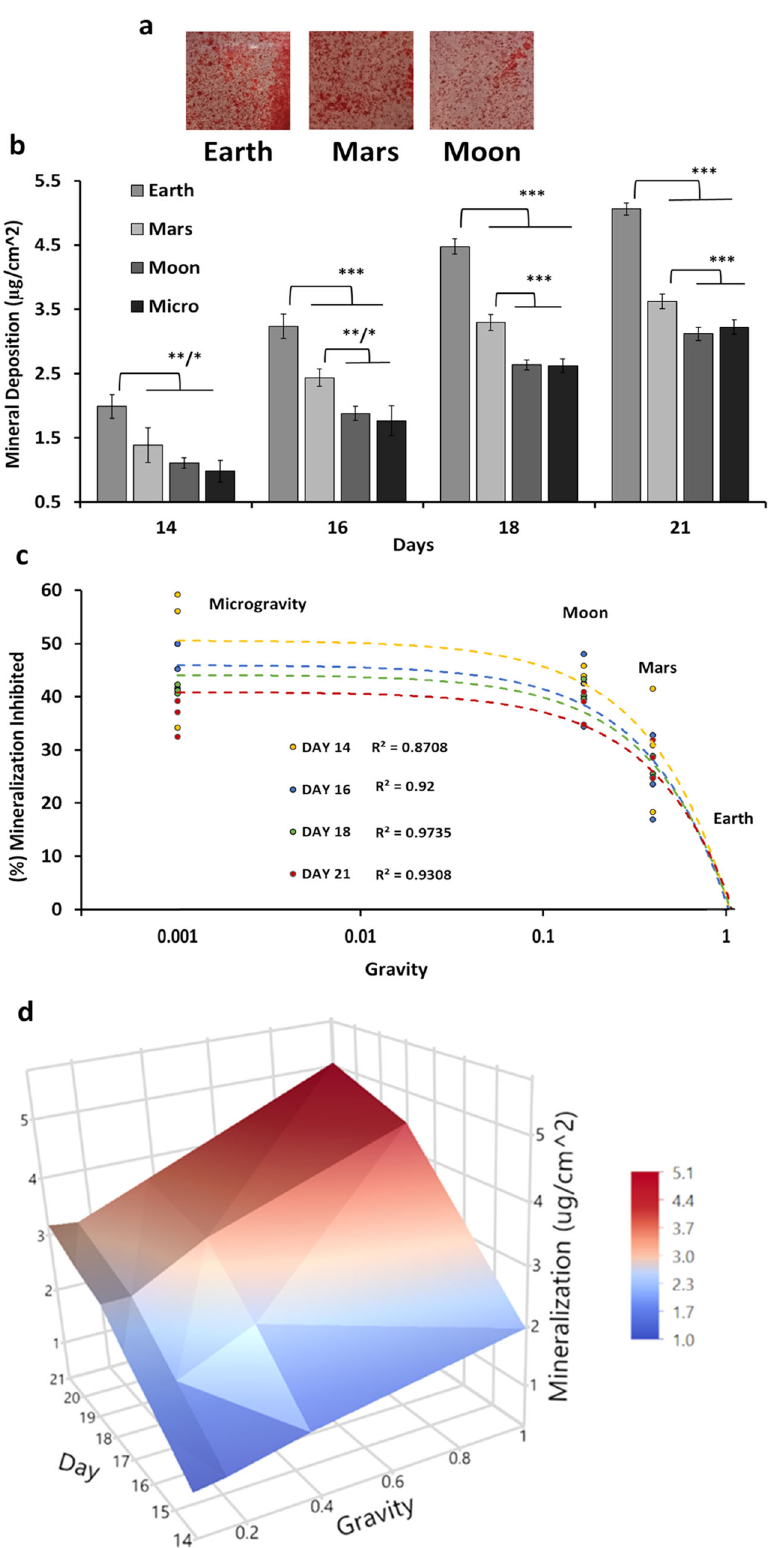
Fig. 4 Effect of simulated partial gravity on long-term mineralization. a Alizarin red-stained mineralized nodules after 18 days on Earth (1 G) and in the RPM exposed to simulated partial -gravities of Moon and Mars. Images are representative micrographs of 1 × 1 cm 2 areas from the bottom of T-12.5 Falcon ™ Tissue Culture Treated Flasks. b Long-term mineralization under variable simulated gravity conditions, quanti fi ed as micrograms of calcium per square centimeter (μg/cm 2 ). c Percentage inhibition of mineralization normalized versus Earth controls with modeled trendlines for various days: 14 days ( R ² = 0.8708), 16 days ( R ² = 0.92), 18 days ( R ² = 0.9735), 21 days ( R ² = 0.9308). d Three- dimensional surface plot and heatmap of the interplay between simulated gravity levels and mineralization over time. Data are presented as means ± standard deviation ( N = 3). Asterisk (*) shows p < 0.05, (**) shows p < 0.01, (***) p < 0.001 as determined by Tukey ’ s post hoc